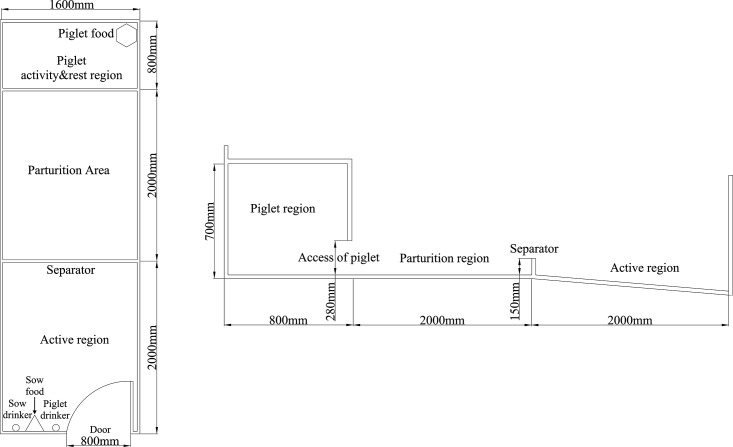
The design of the farrowing pens.